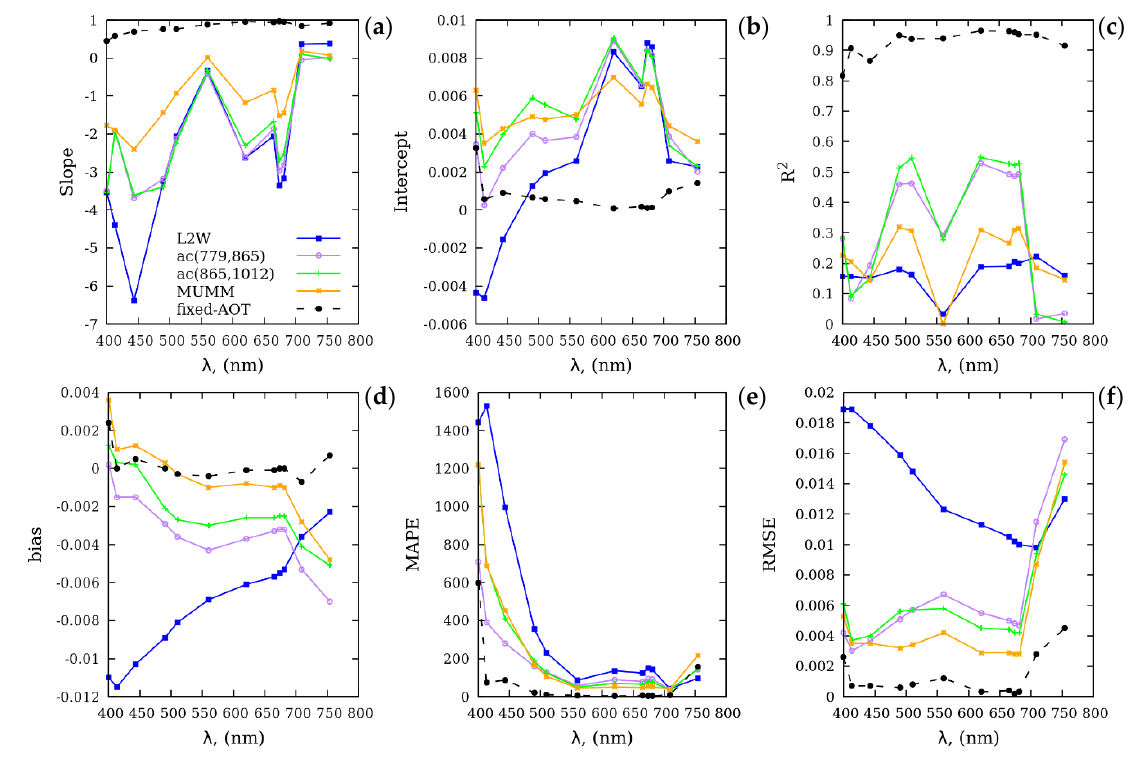
Figure 8. Spectral distribution of the slope ( a ), the intercept ( b ), determination coefficient R 2 ( c ), bias ( d ), MAPE ( e ), and RMSE ( f ) according to different atmospheric correction algorithms. The number of match-ups is 127.